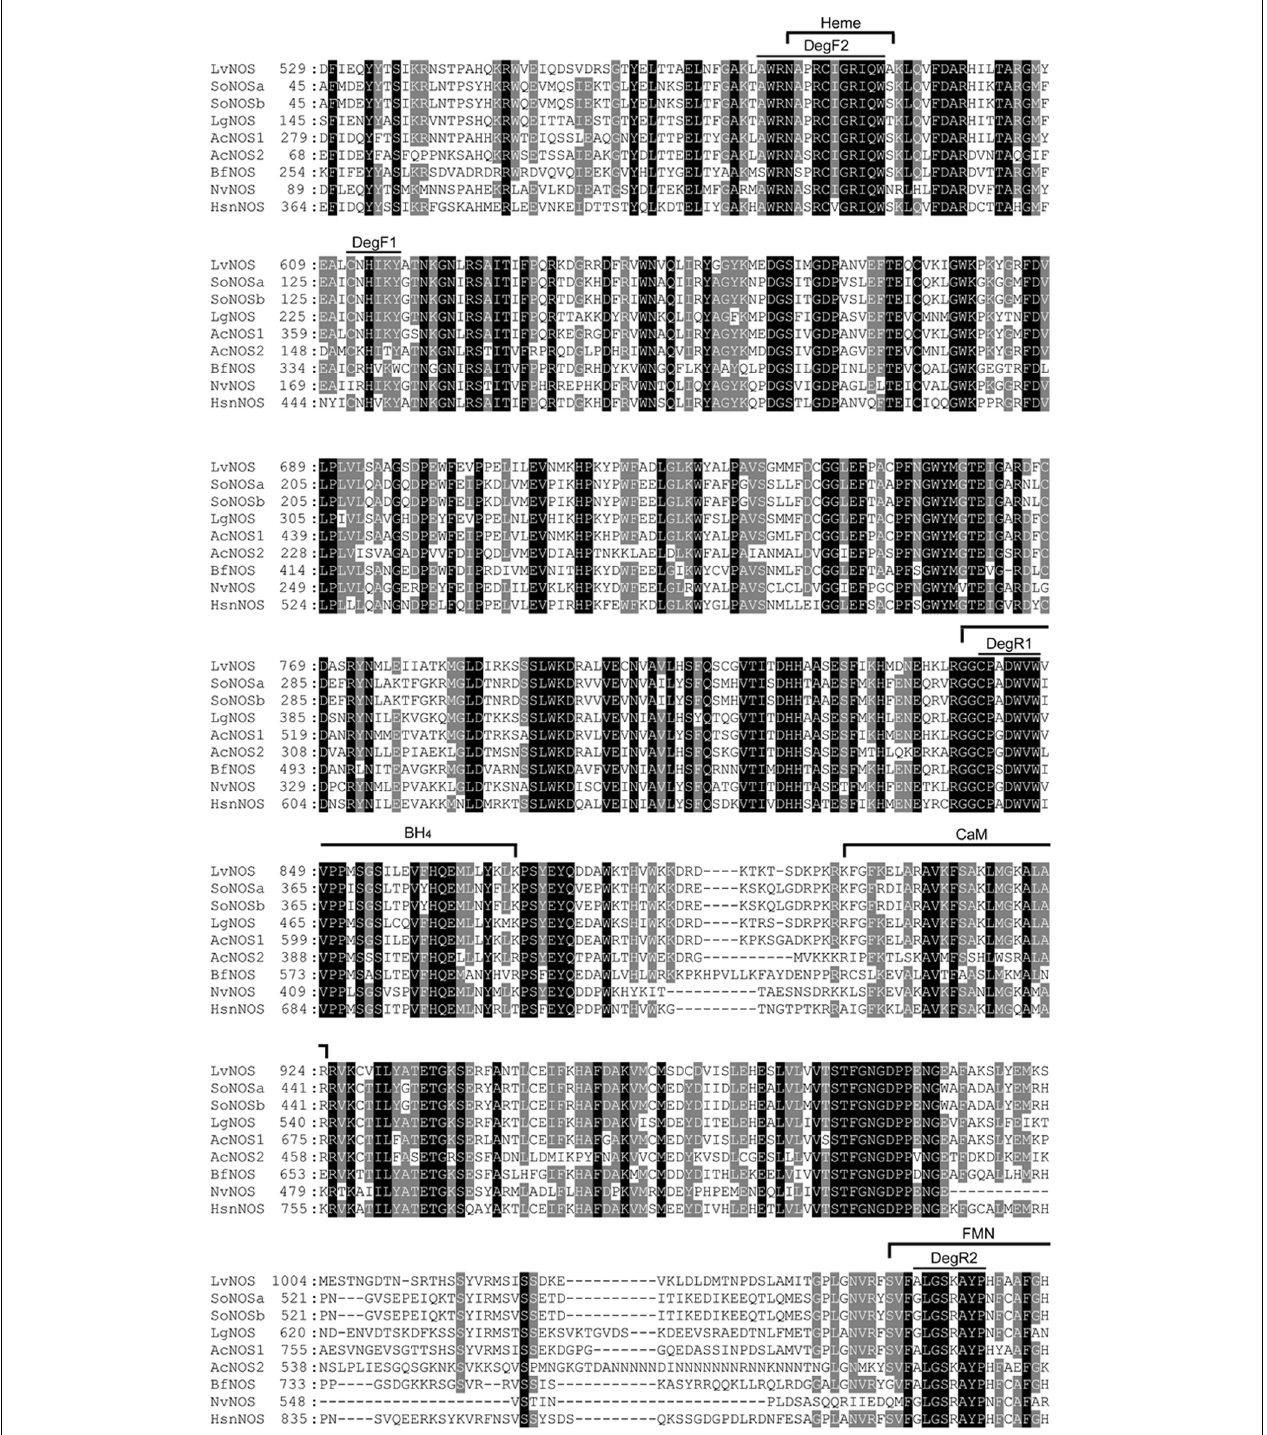
FIGURE 2 | Multiple sequence alignment of NOS derived amino acid sequences. Black shading indicate completely conserved residues; gray shading indicates semi-conserved residues. The locations of amino acid sequence used to design degenerate primers are indicated by DegF1, DegF2, DegR1, and DegR2. Homo sapiens neuronal nitric oxide synthase